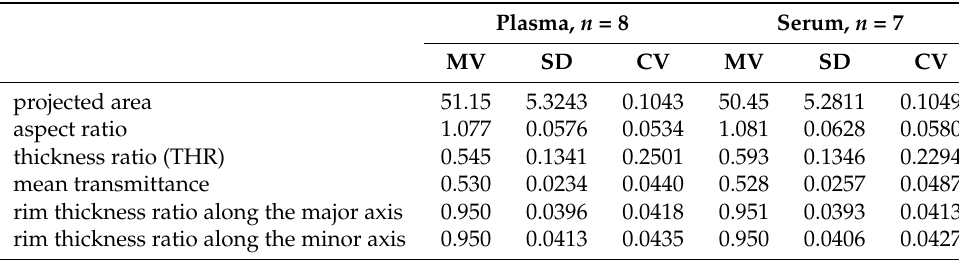
Table 2. Mean values of the means (MV), mean values of the standard deviations (SD), and mean values of the coefficients of variation (CV = MV/SD) of the distributions 1 to 6. Results for RBCs suspended in plasma and serum.